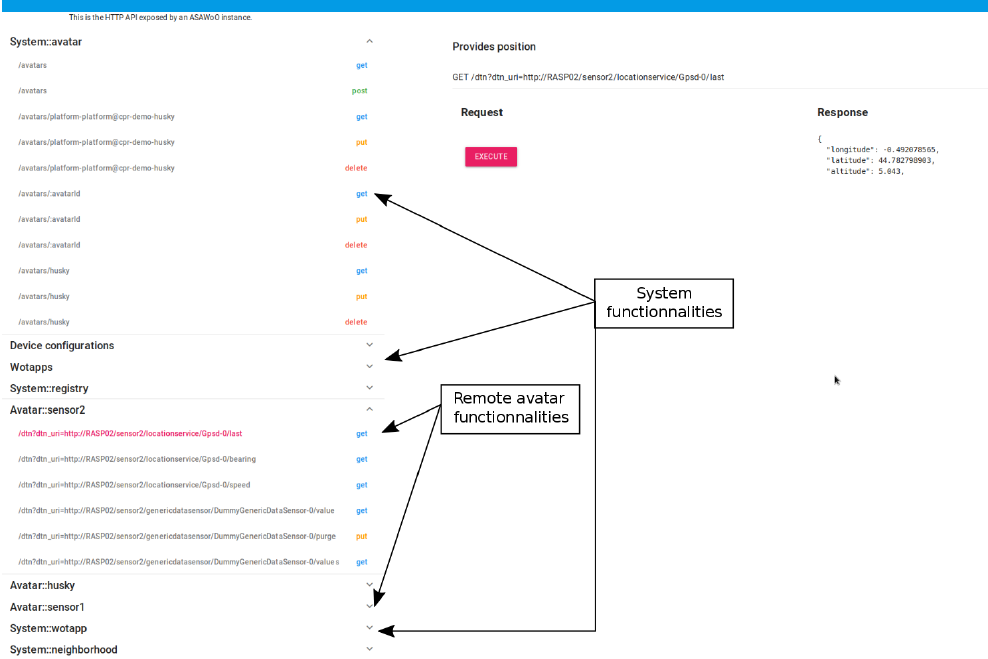
Figure 11. Screenshot of ASAWoO administration